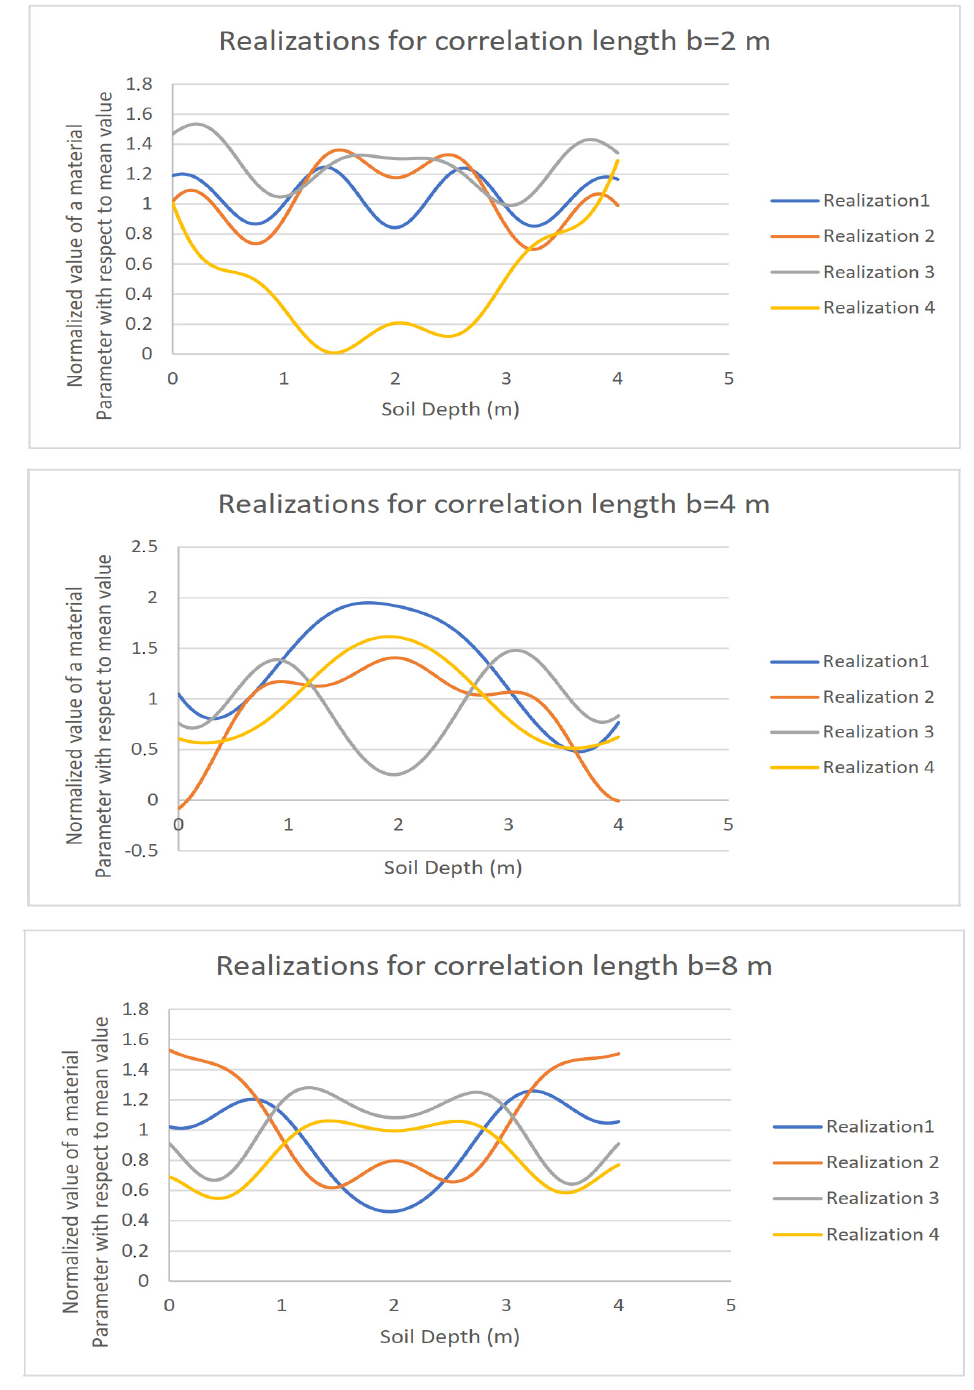
Figure 6. Schematic representation of the realizations of the random field simulations for the correla- tion lengths b = 2 m , b = 4 m, b = 8